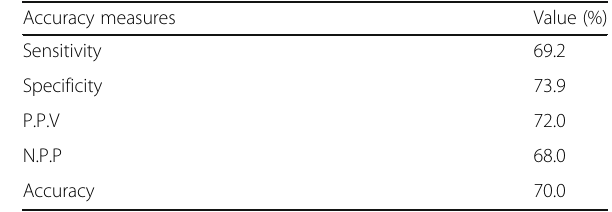
Table 5 Accuracy measures of chromosome/chromatid breaks in predicting DS pregnancy in young